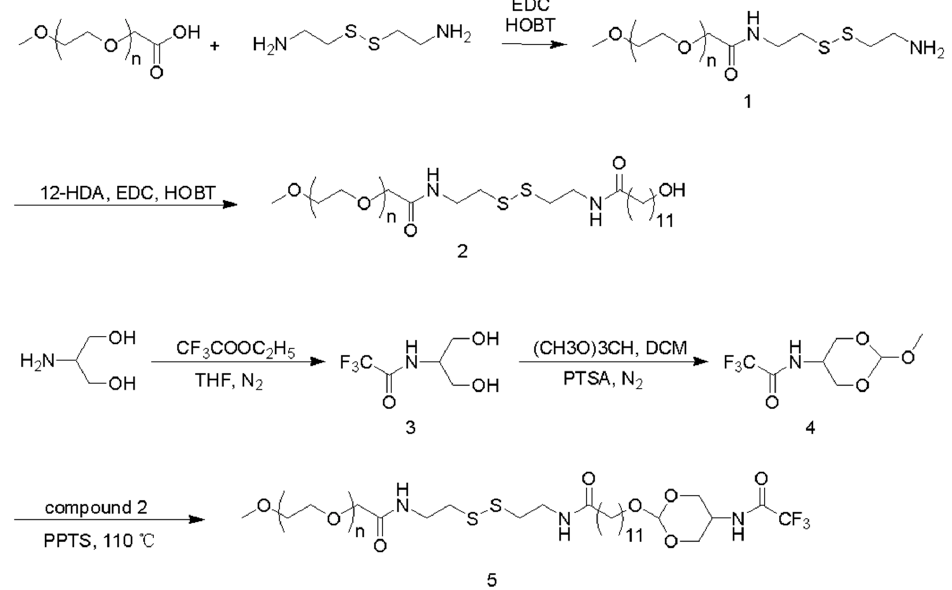
Figure 1. Synthesis route of PCT polymers.